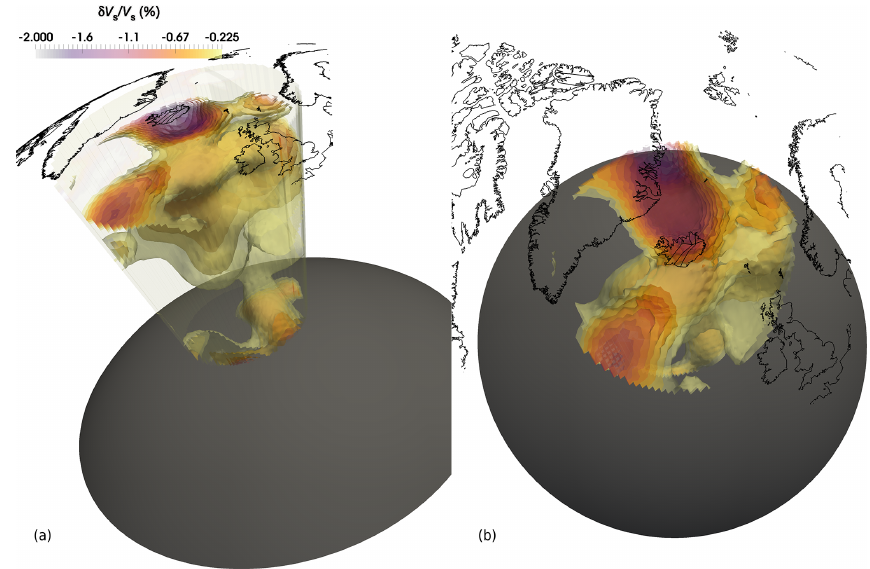
Figure 1. (a) Shear velocity ( V s ) variations in model SEMUCB-WM1 (French and Romanowicz, 2014), within a radius of ∼ 1500km from the present-day Iceland plume, extending from 200km below the surface to the CMB, are iso-surfaced at intervals of 0.25, within the range shown. The Iceland plume can be clearly seen emerging from the deep lower mantle, and extending down to the CMB (grey shell). (b) Same as in (a) , but shown from a different 3-D perspective to better highlight the shear velocity distribution below the